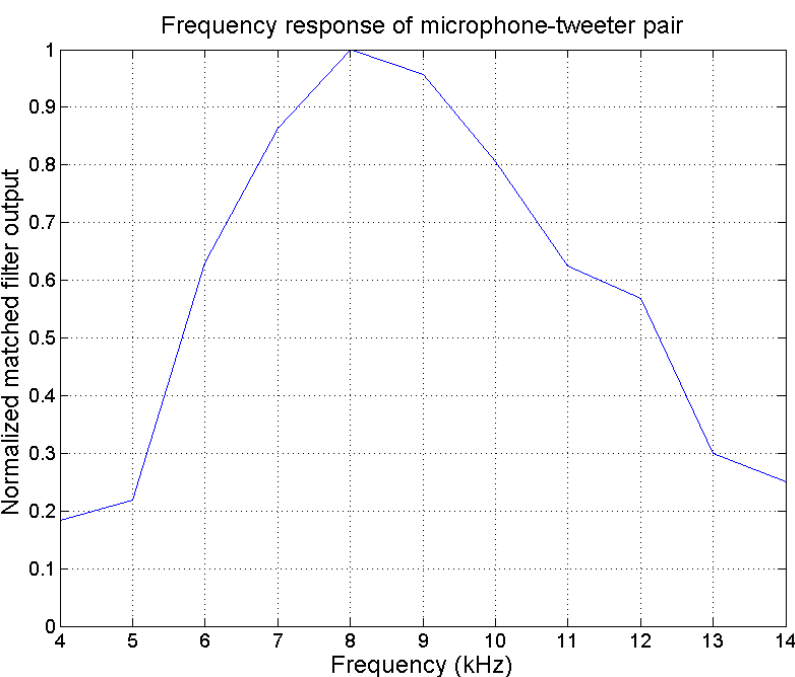
Figure 17. Frequency response of